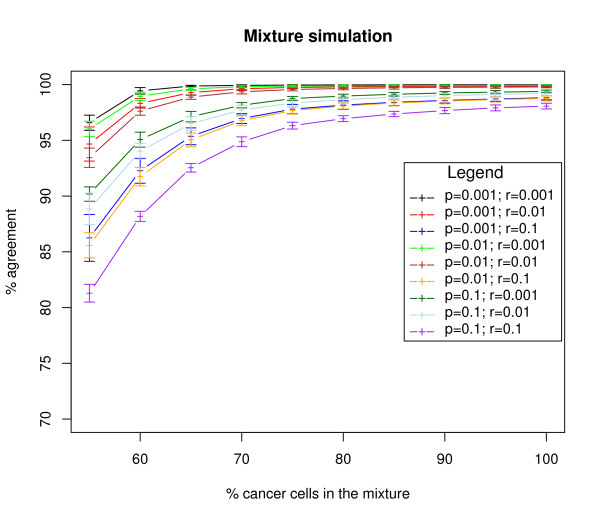
Accuracy of our method on simulated data. The percentage of agreement between the recovered state and the original state in the simulated data sets is plotted as a function of the population mixture (percentage of tumour cells in the sample). The simulation were done using different combinations of transition parameters.